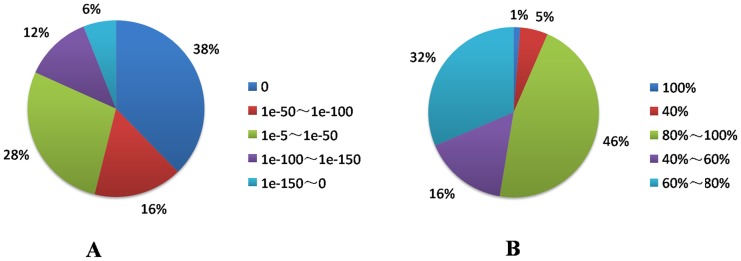
Landscape of unigene distribution in the blunt snout bream.(a) E-value distribution of unigenes searched against public databases with an E-value cut-off of 1E-50. (b) Identity distribution of unigenes searched against public databases with an E-value cut-off of 1E-50.